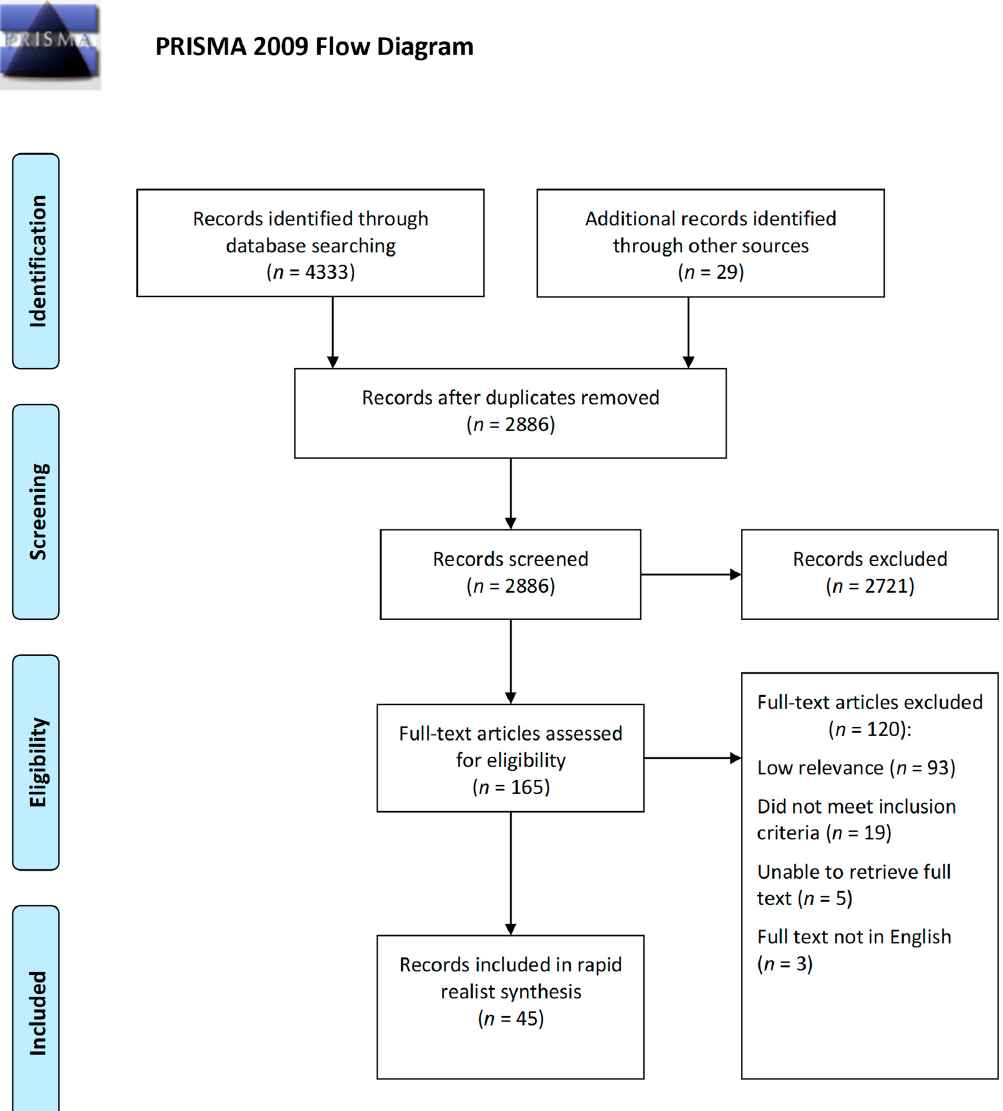
Figure 2. Adapted PRISMA Flow Diagram for RRR.